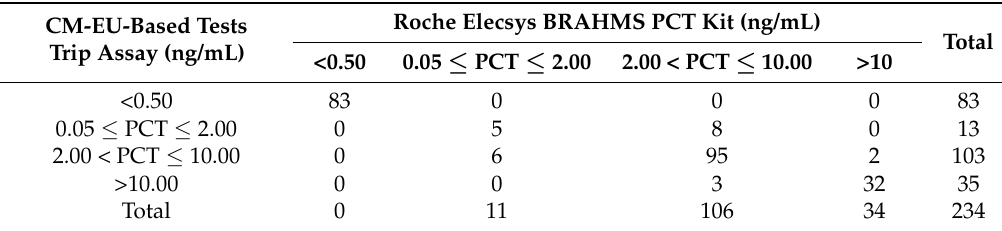
Table 4. Consistency analysis of the two